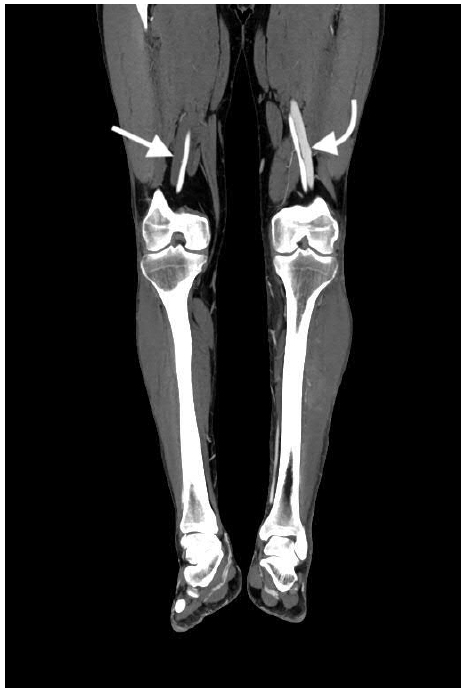
Figure 11. Coronal image of the bilateral lower extremities in the arterial phase following left calf trauma. There is opacification of the left femoral vein (curved arrow) in the arterial phase, indicative of arteriovenous fistula. Note that the right femoral vein (arrow) is not opacified.